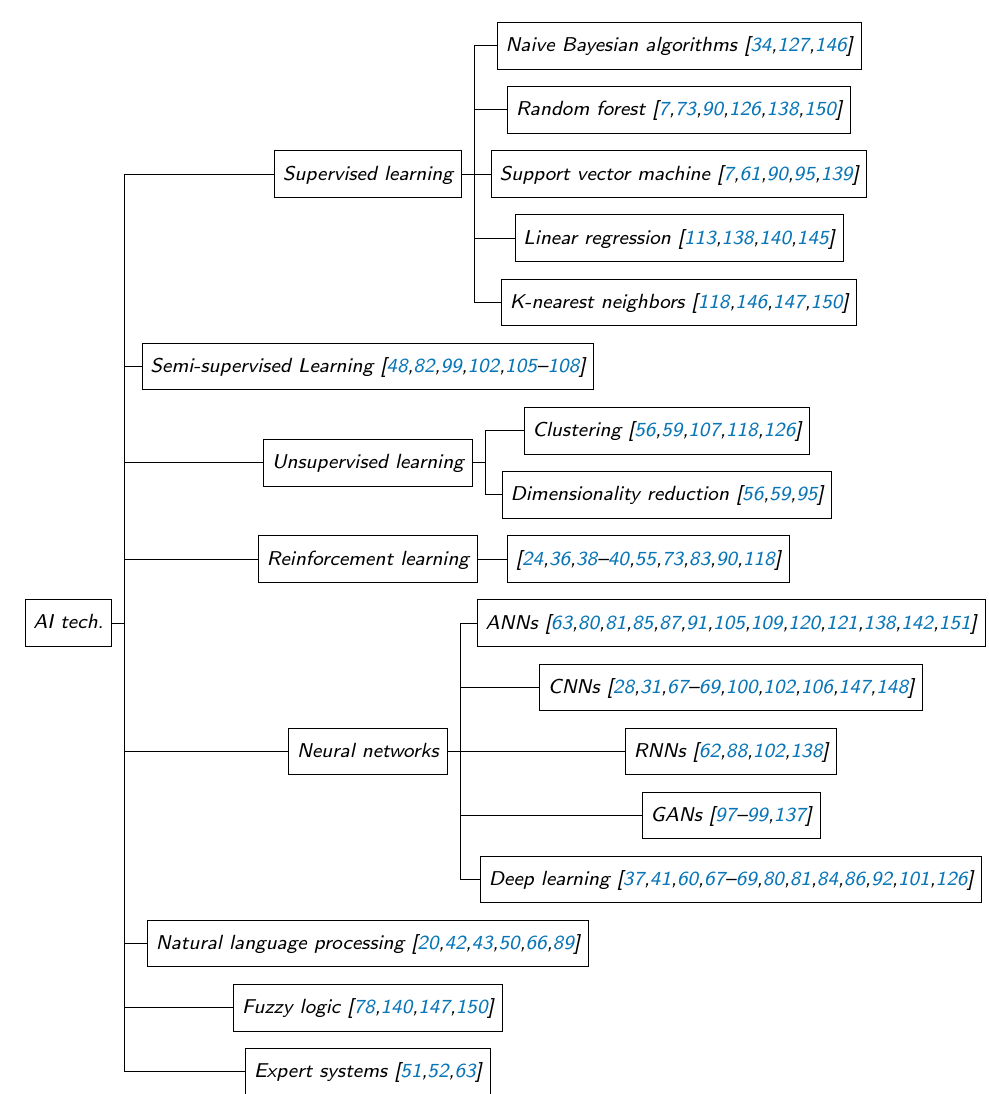
Figure 2. Artificial Intelligence techniques for space